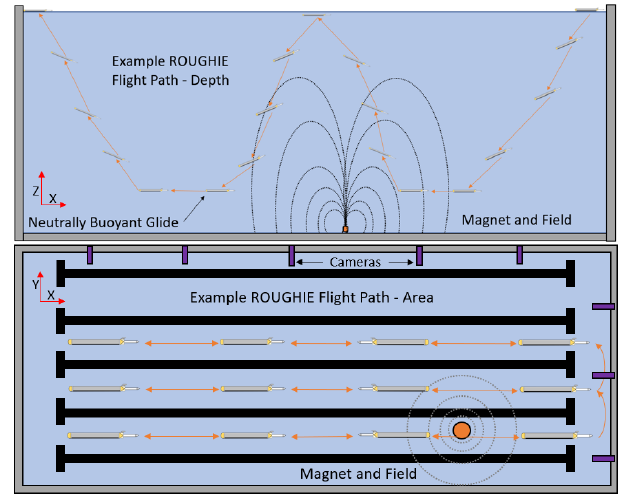
Figure 3. Illustration showcasing a single idealized example ROUGHIE data collection flight path across the testing volume ( Top ) and an Illustration showing an idealized lawnmower coverage path by the vehicle through the entire testing area ( Bottom